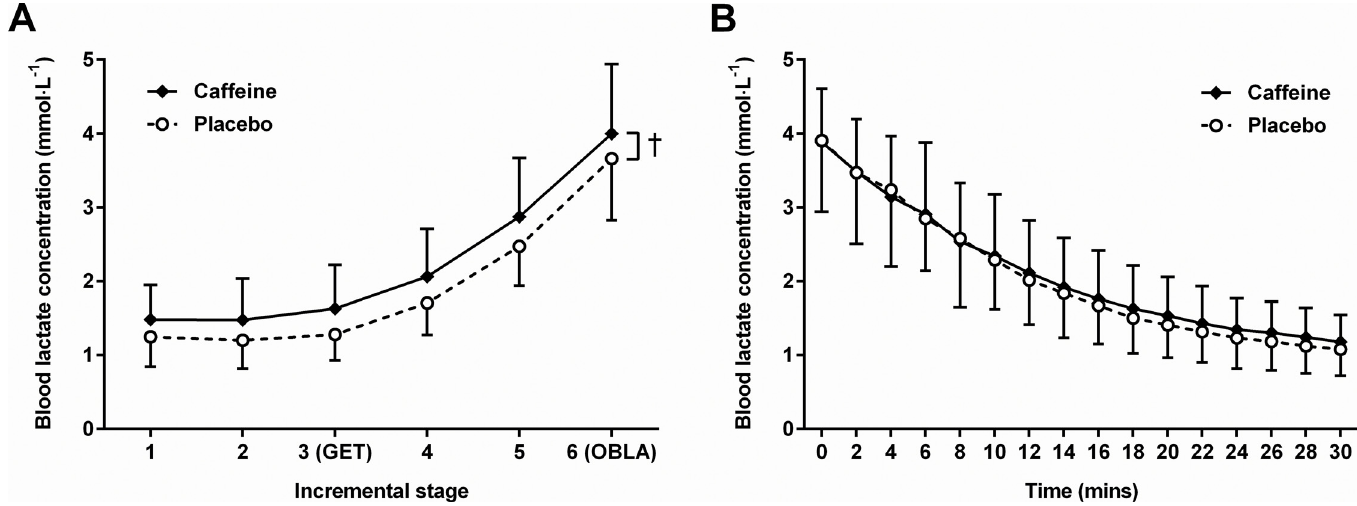
Fig 1. The effects of caffeine supplementation on blood lactate concentration during submaximal incremental exercise (A); and in recovery from submaximal incremental exercise designed to achieve an end-exercise blood lactate concentration of 4 mmol (cid:1) L -1 (B). Values are means; bars are standard deviations . GET = Gas exchange threshold; OBLA = Onset of blood lactate accumulation. † = significant main effect of supplement.